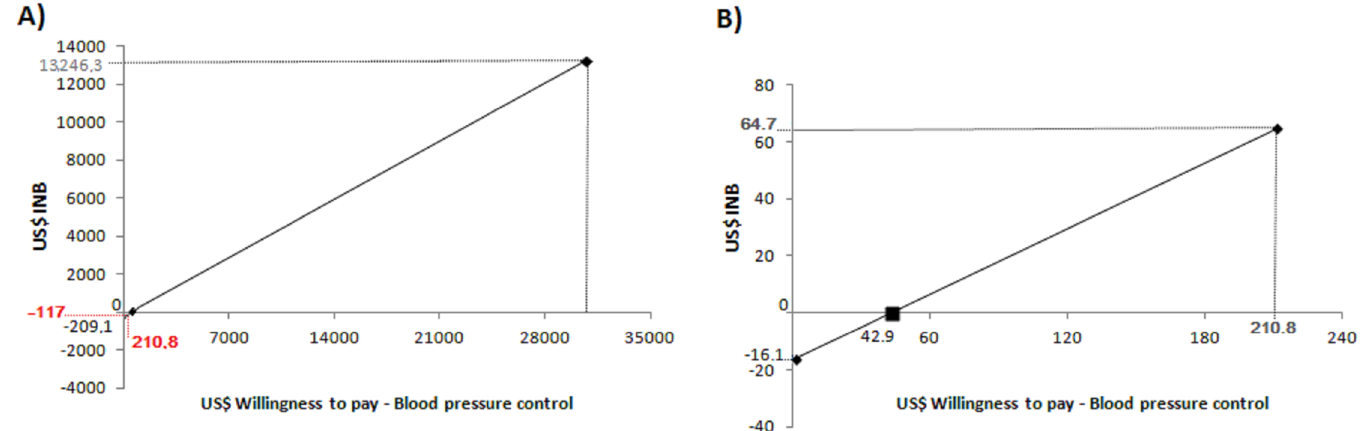
Fig 3. Analysis of the one-way sensitivity performed by the incremental net benefit to pharmaceutical care. INB = Incremental net-benefit. A) Structuring the sensitivity analysis of the incremental net benefit to pharmaceutical care, considering the minimum value of 1 dollar and maximum of 3 x GDP per capita of Brazil used as threshold for the willingness to pay for pharmaceutical care; B) Sensitivity analysis for the incremental net benefit to pharmaceutical care, considering the spending with pharmaceutical care as the willingness to pay for pharmaceutical care after discharge of patients. The maximum value used as a threshold for willingness to pay was the cost of pharmaceutical care calculated in this study. Negative INB values represent a non-compensatory valuation of PC for investment, and positive INB values represent valuation that is compensatory as investment.